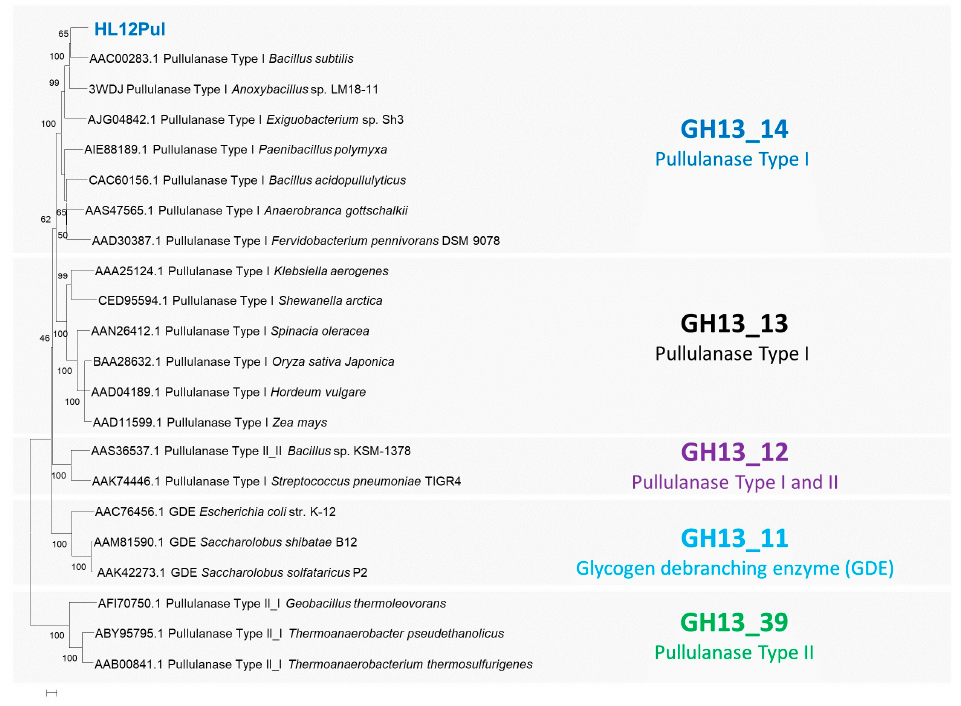
Figure 1. Evolutionary analysis based on full-length amino sequence alignment of HL12Pul and α -glucan debranching enzymes classified into various subfamilies of glycoside hydrolase family 13 (GH13) obtained from [3,9]. The neighbor-joining tree was constructed using the MEGA version 11 using the bootstrap method for estimation phylogenetic evolutionary via 1000 bootstrap